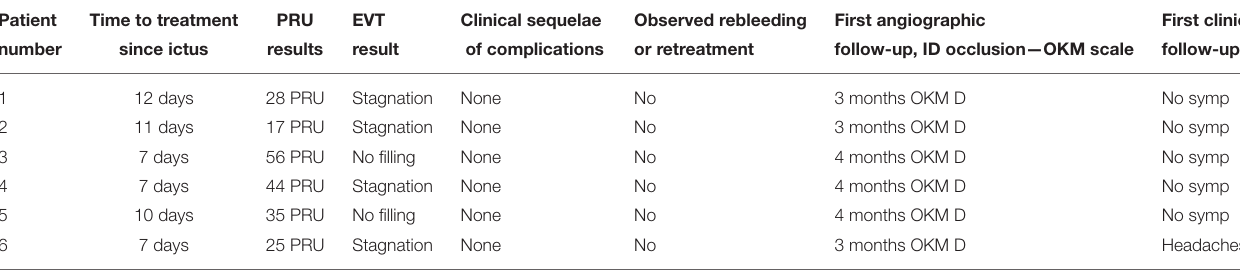
TABLE 2 | Procedural, clinical, and follow-up angiographic results after the endovascular intervention.